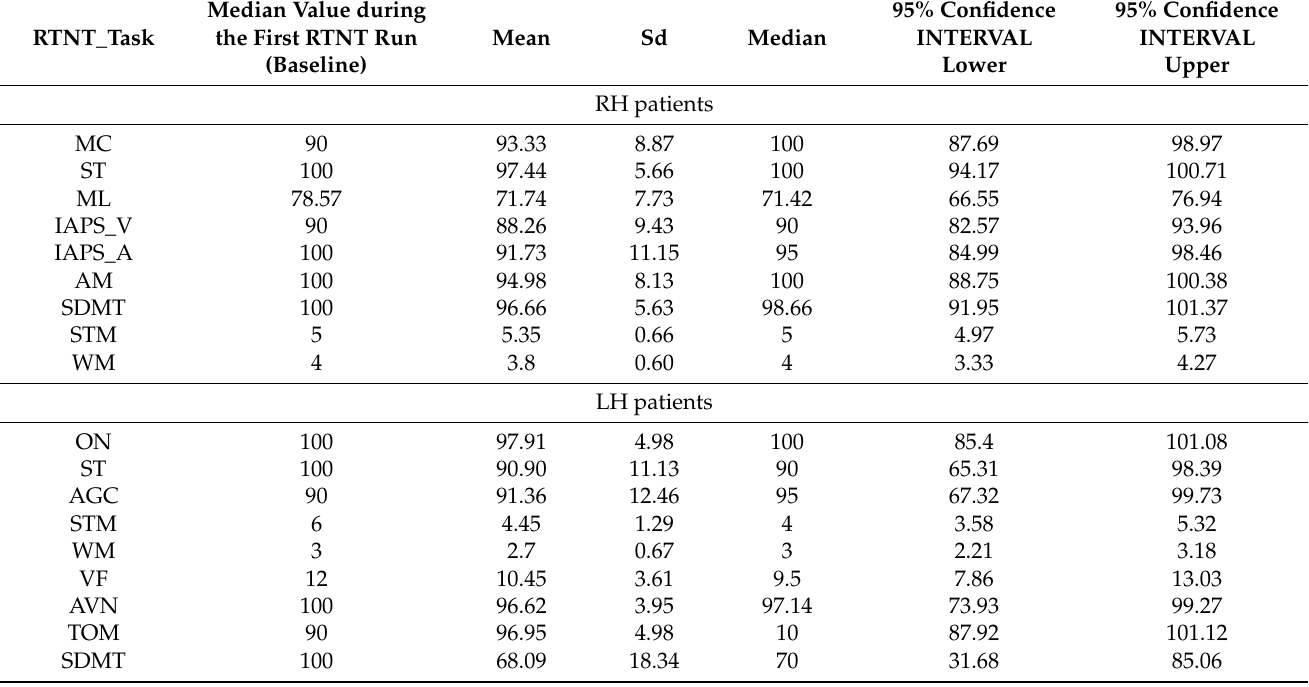
Table 4. Patients’ RTNT performance during